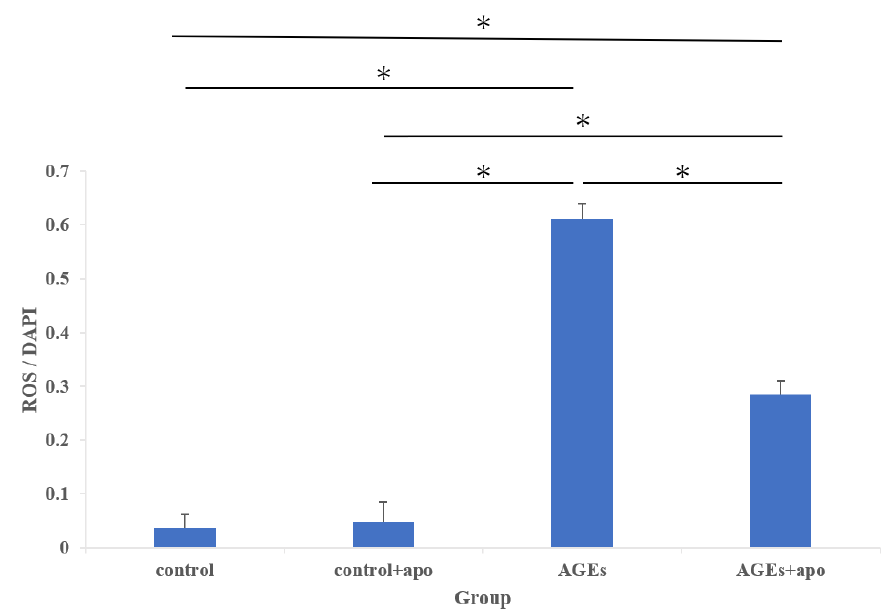
Figure 6. The quantification of ROS generation. The generation of reactive oxygen species was evaluated by fluorescence intensity normalized to cell number. ROS production in the AGEs group and the AGE + apo group was significantly higher than in control + apo groups at 48 h. ROS production in the AGEs + apo group was significantly lower than in the AGEs group. * p < 0.05. DAPI, 4 ’ ,6- diamidino-2-phenylindole.